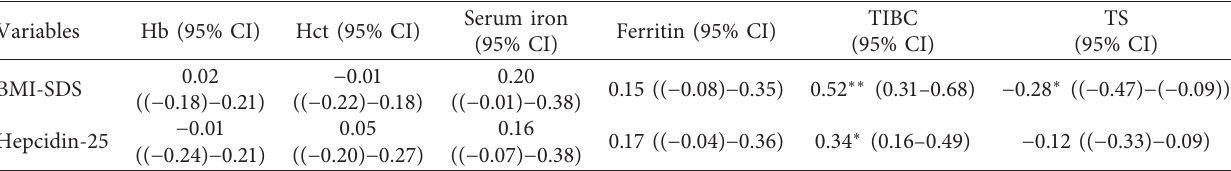
Figure 1: Correlation between serum hepcidin-25 and BMI-SDS. Table 2: Correlations between BMI-SDS, serum hepcidin-25, and iron profiles in all